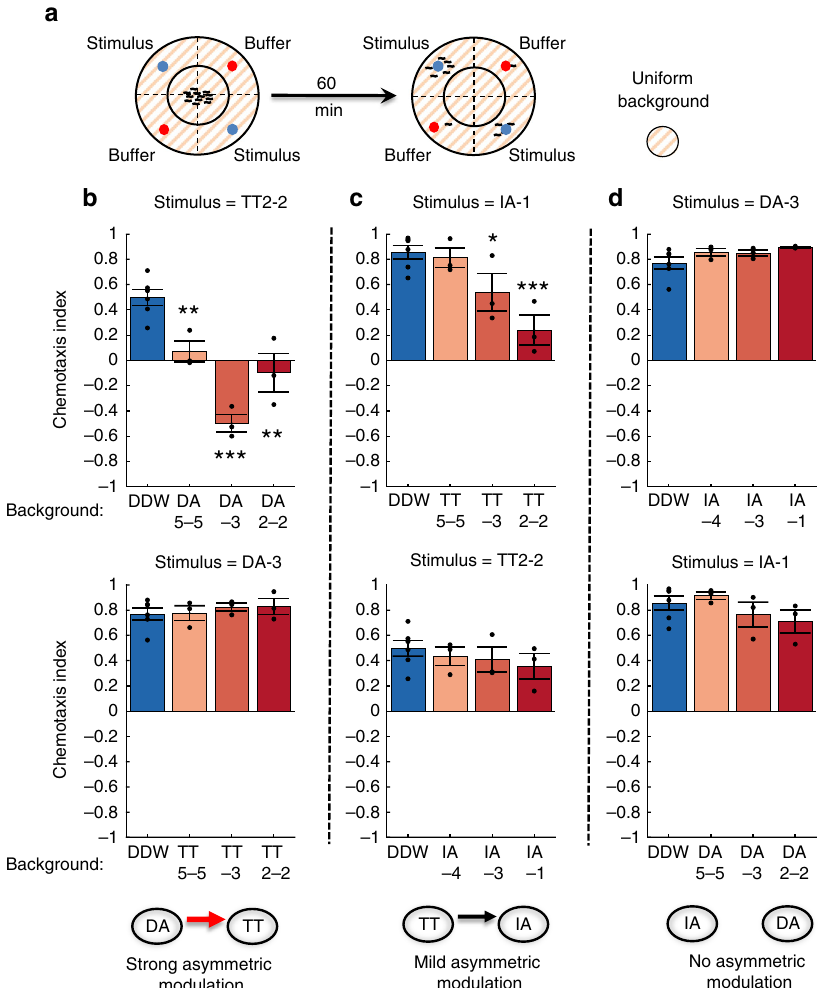
Fig. 4 Asymmetric cross-modulatory effects between pairs of stimuli. a Scheme of the experimental arena. Prior to the experiment, the background stimulant was uniformly applied to a fi lter paper placed on the internal face of the plate cover. b – d Effects of various background concentrations (shown horizontally) on attraction toward a target stimulus (noted at the top of each panel). Note the asymmetric cross-modulatory effects between DA & TT, and between TT & IA. Numbers next to the stimulus specify its dilution. * p < 0.05, ** p < 0.01 *** p < 0.001 (two-sample t test). For DDW background, N = 6 experimental days; for other backgrounds, N = 3. Each experimental day consisted of 2 – 4 plates of each condition. Scattered dots are the mean chemotaxis indexes of plates in each experimental day. Error bars denote